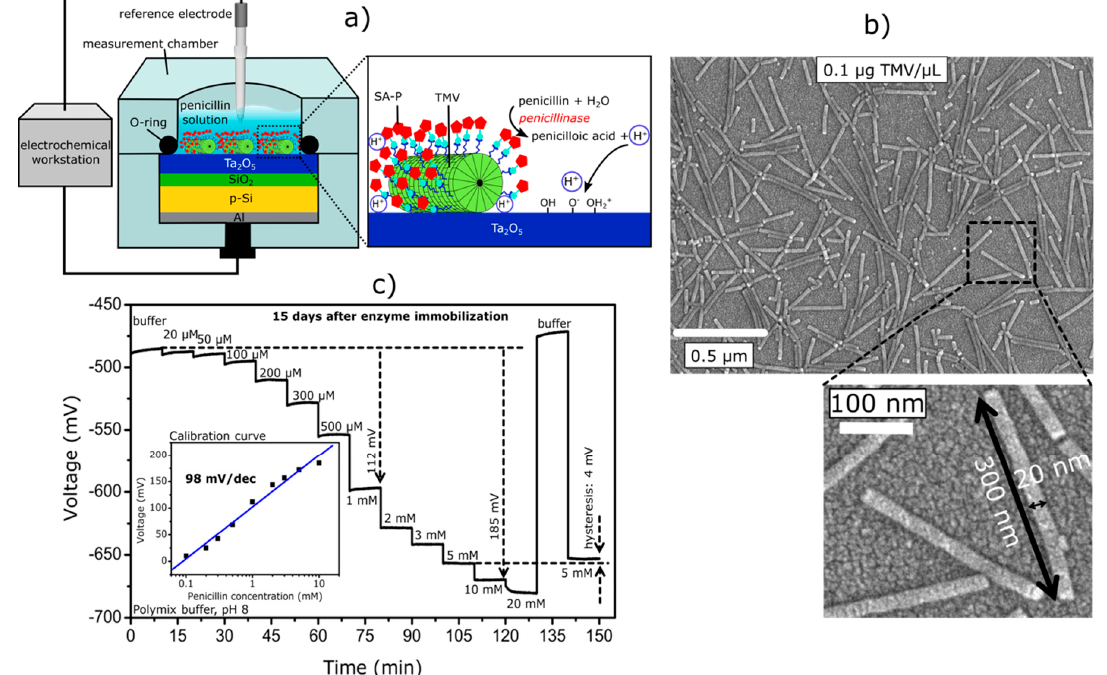
Figure 4. Schematic structure of an enzyme-modified capacitive EIS (EnEIS) biosensor modified with tobacco mosaic virus (TMV) particles as enzyme nanocarriers ( a ), scanning electron microscopy image of TMV particles on the Ta 2 O 5 surface ( b ), and the sensor signal in buffer solution with different penicillin concentrations ( c ). Adapted from Ref. [103] with permission of Elsevier.